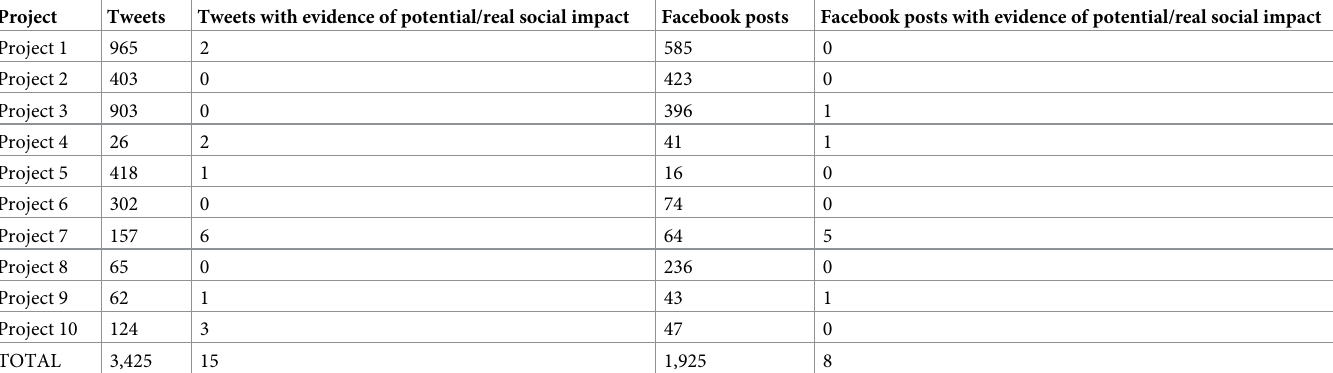
Table 11. Total number of tweets and Facebook posts with evidence of social impact.